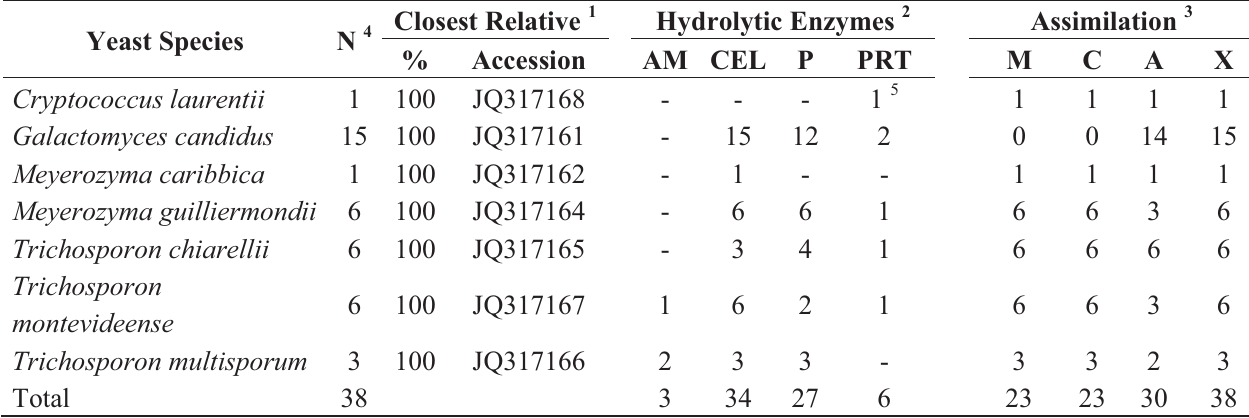
Table 2. Enzymatic activity and assimilation profile of yeasts isolated from fungus gardens of Acromyrmex . Yeast Species